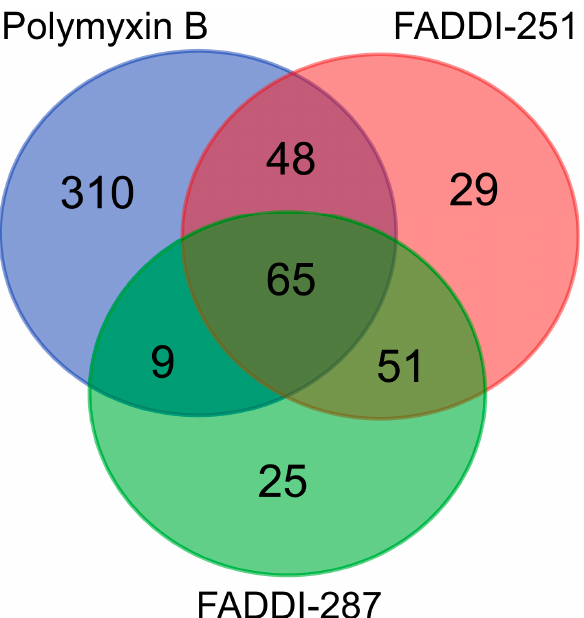
Figure 3. Numbers of common and unique DEGs in HK-2 cells induced by polymyxin B, FADDI-251 and FADDI-287.